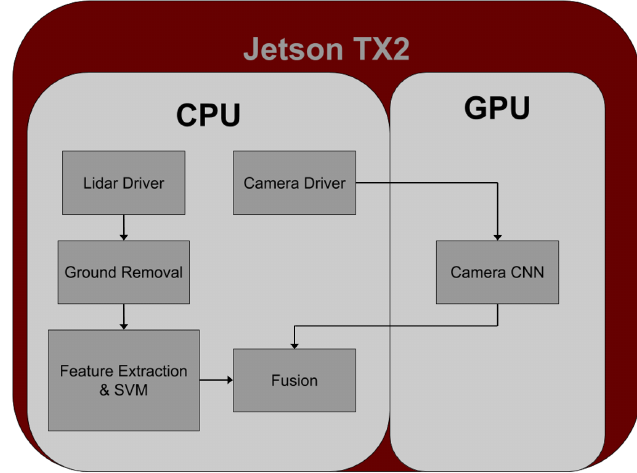
Figure 4. ROS dataflow on Jetson TX2.